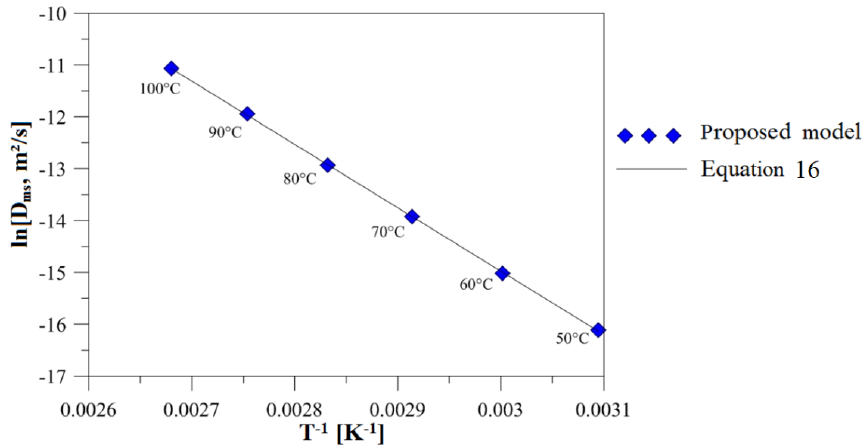
Figure 12. Mass diffusivity in brick according to Arrhenius Law.